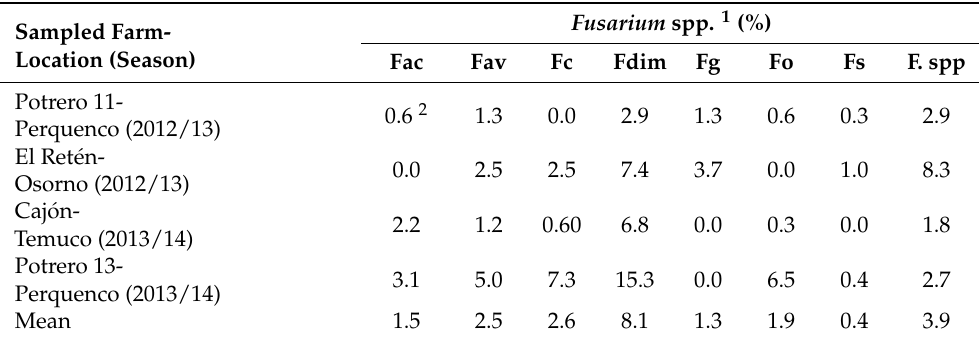
Table 2. Percentage of Fusarium isolated from the first internode of wheat culms obtained from four intensively sampled fields in southern Chile during the grain-filling